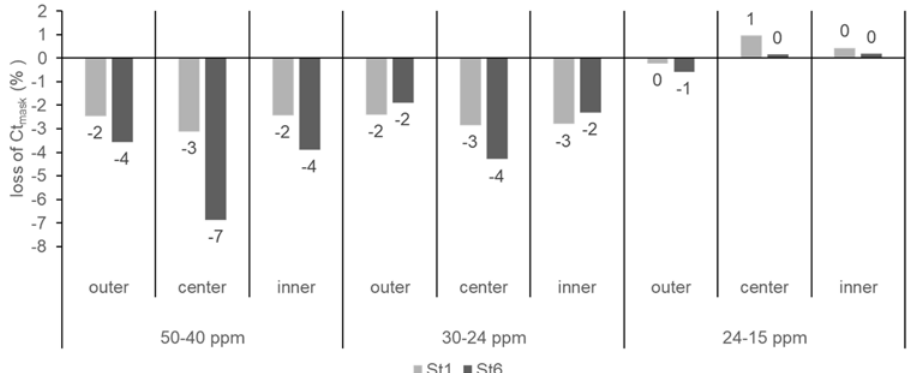
Figure 5. Net C loss of Ct mask for each C-type (%) calculated from the difference between Ct mask in the fresh and degraded masks (Table 5) that were incubated as cuts from single layers for 1 and 6 months (St1, St6). Negative values are net losses; positive values correspond to net production.